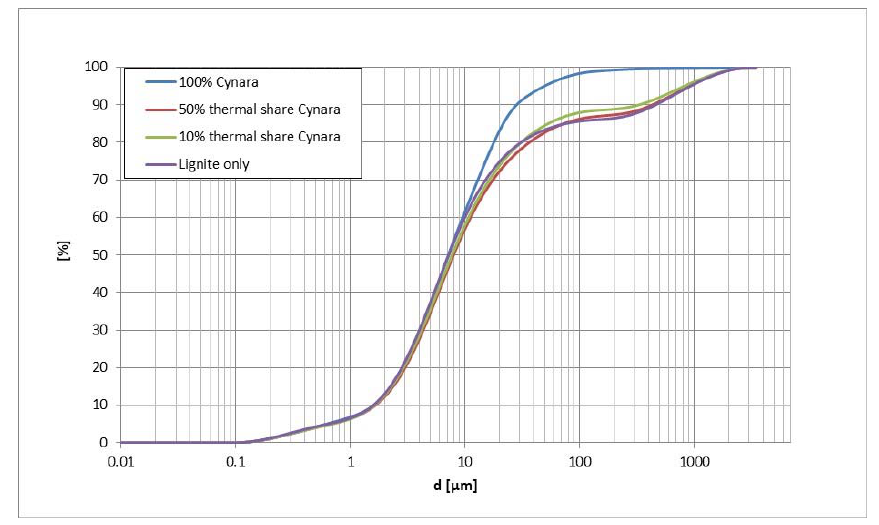
Figure 5. Particle size distribution of representative bulk fly ash samples from Cynara co-firing tests.